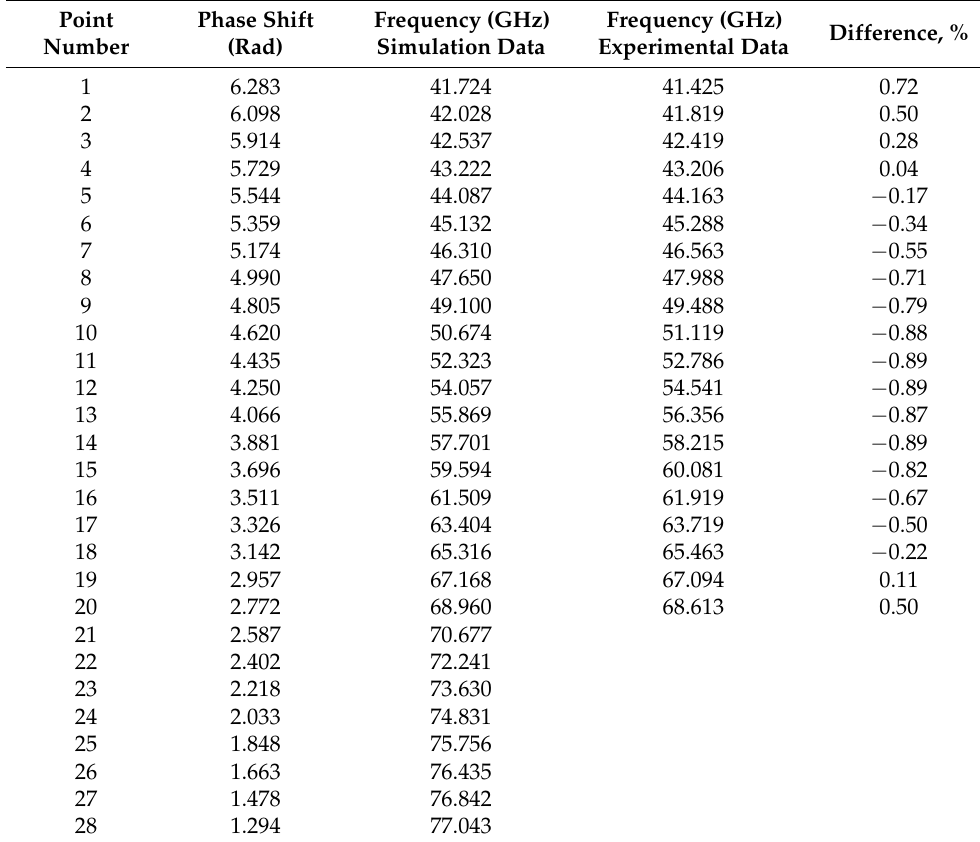
Figure 9. Comparison of the experimentally measured dispersion characteristic with the numerically simulated for the initial model and the model with modified corrugation profile. Table 2. A comparison of the dispersion characteristics obtained from the numerical simulations and reconstructed from the experimental measurements.